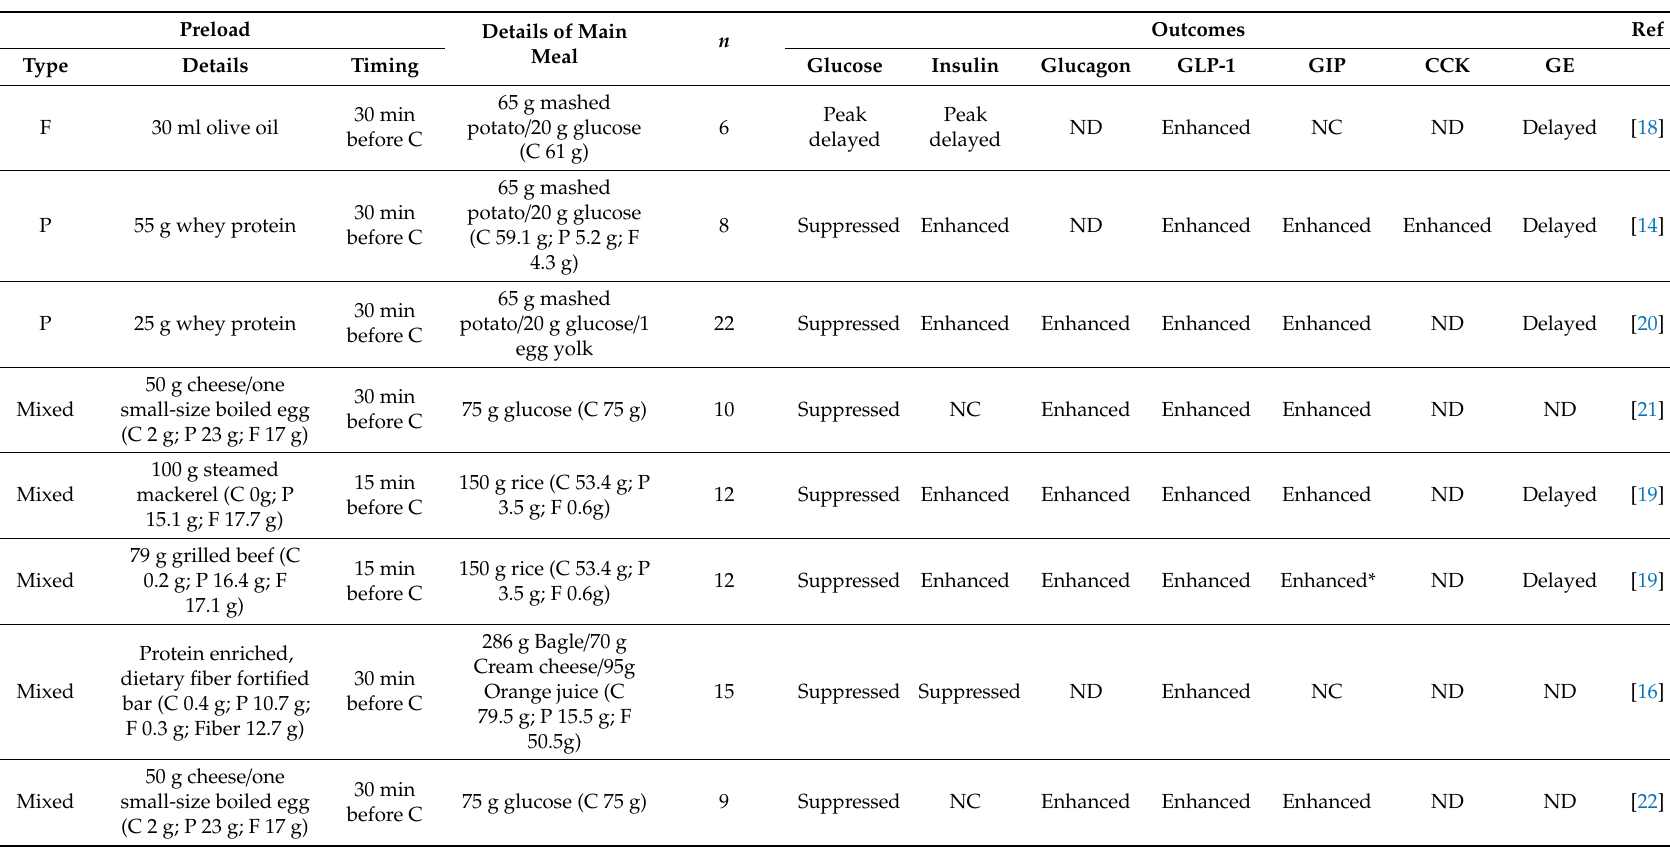
Table 1. Preloading fat, protein, and their mixture with and without dietary fibers before carbohydrate in individuals with type 2 diabetes.